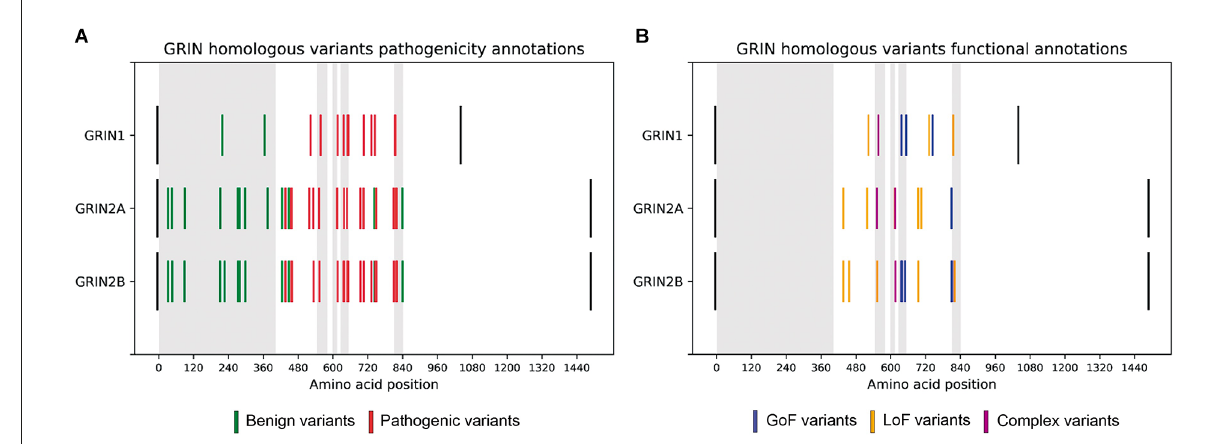
FIGURE1 (A) Comparative analysis of GRIN homologous variants pathogenesis in GRIN variants Database. Disease-associated variants are colored in red and benign variants are colored in green. Black bars represent the initial and final amino acids of canonical GluN1, GluN2A, and GluN2B subunits. Gray rectangles represent the amino-terminal domain, and transmembrane domains (TM1, TM2, TM3, TM4, respectively). Homologous variants present the same pattern of pathogenesis across GluN1, GluN2A, and GluN2B subunits. (B) Functional annotations of GRIN homologous variants in GRIN variants Database. LoF variants are colored in yellow, while GoF variants are colored in